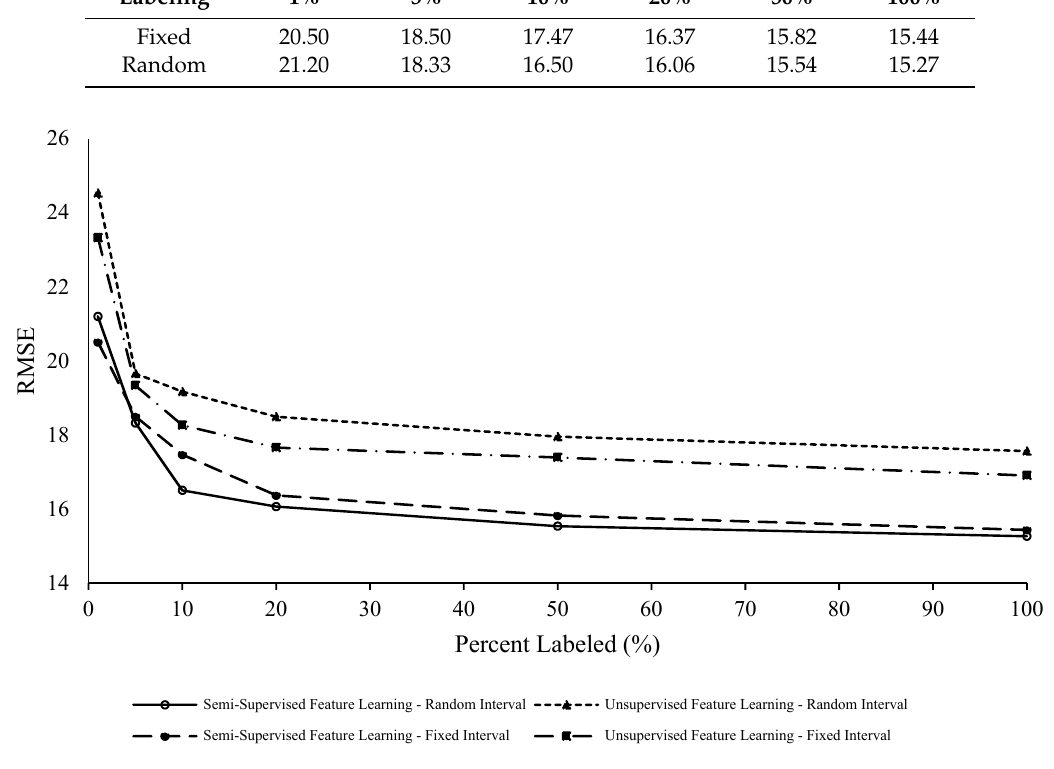
Figure 9. FD001 RMSE versus percent labeled (%).